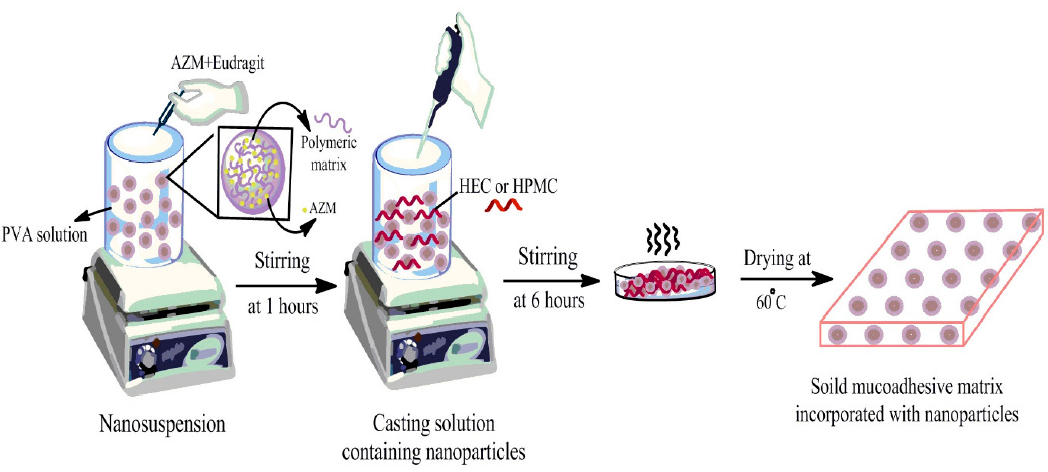
Figure 1. The experimental procedure for the azithromycin (AZM) nanoparticle and solid film preparation.